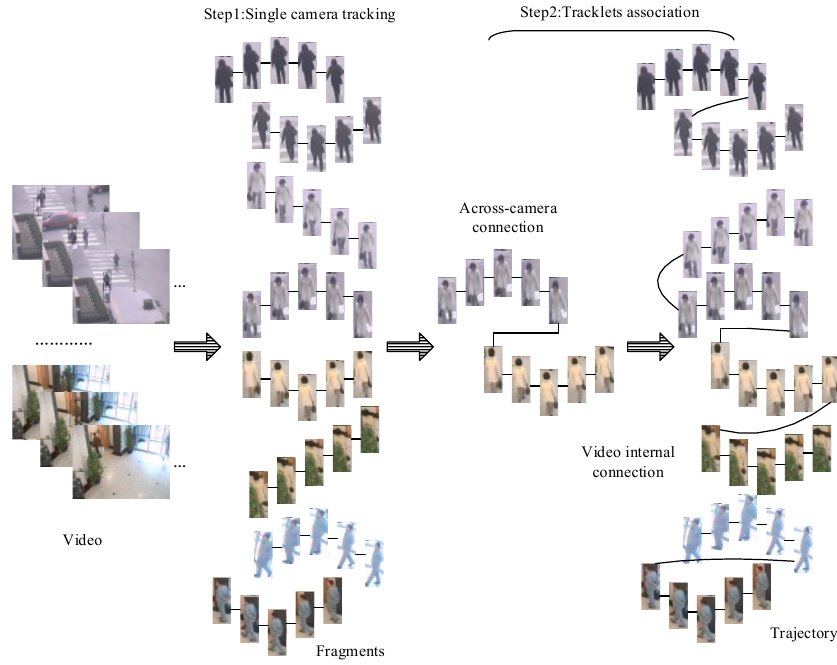
Figure 7. The basic processes of multi-targets tracking across multiple cameras.